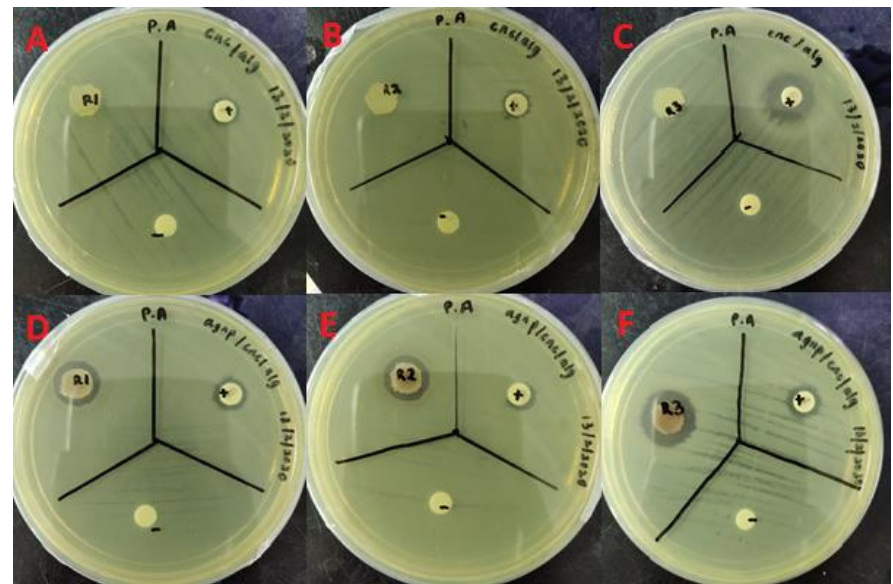
Figure 10. Disc diffusion test of the CNC/Alg hydrogel film ( A – C ) and the bioAgNP-CNC/Alg hydrogel film ( D – F ) against P. aeruginosa USM-AR2. BioAgNP-CNC/Alg and CNC/Alg are denoted (R), streptomycin is denoted (+), and dH 2 O is denoted ( − ). This test was conducted in